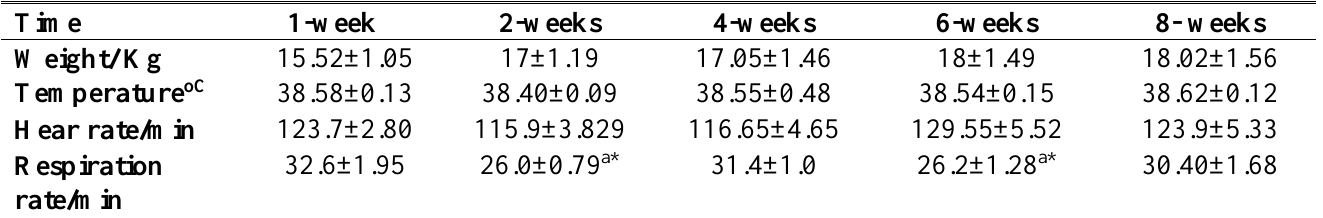
Table 2. Clinical parameters in experimentally induced zinc deficiency in goats